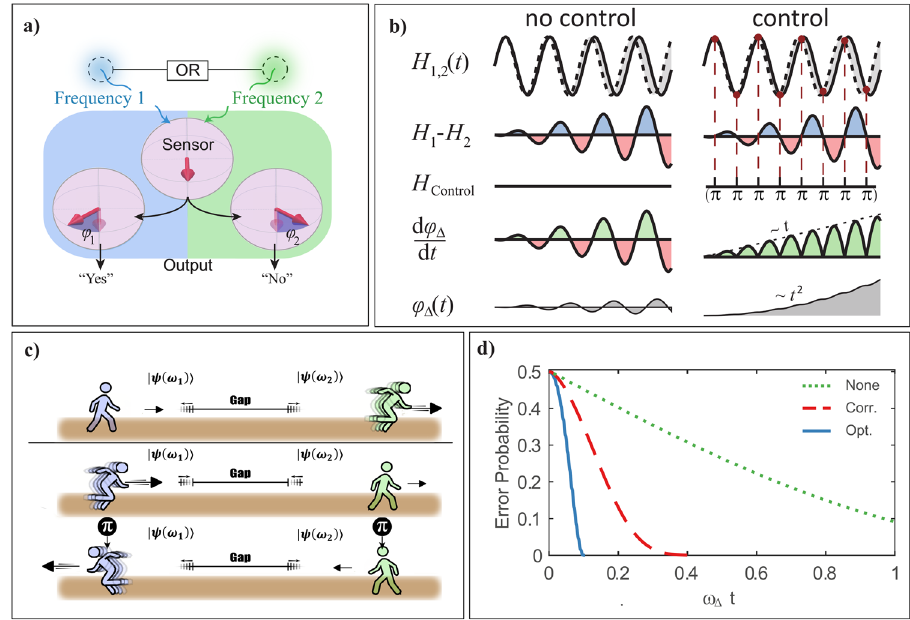
Fig. 1 Quantum-frequency discrimination. a The sensor state is tailored to depend on each frequency so that the sensor is driven in orthogonal directions. Readout of the state provides a “ Yes/No ” answer. The task is to correctly identify the frequency with highest fi delity in the shortest time. b Phase accumulation for frequency discrimination. For each Hamiltonian H i t ð Þ ¼ B sin ω i t þ θ ð Þ σ Z ¼ H i t ð Þ σ Z , the sensor accumulates a different phase. Left: without control, the phase difference φ Δ oscillates and increases only slowly. Right: optimal control in this scenario implies applying π -pulses whenever the sign of H 1 – H 2 changes, leading to a monotone phase increase with t 2 . c Geometrical picture of the optimal protocol. The states of the sensor can be thought of as two runners, where the aim is to maximize the gap between them, which is equivalent to the angle between the states. The speed of each runner is proportional to H i t ð Þ . As soon as the initially slower runner becomes faster, we change their direction of motion to ensure an increasing gap. Note that the sketch just demonstrates the idea and the runners actually move on circular orbits. d Error probability as a function of time for three different strategies: optimal control and a single measurement (solid blue), this strategy is optimal and sets the fundamental error limit (see Eqs. 3 and 4). Correlated measurements (dashed . No control (dotted green). More details on this comparison are found in red), in this illustration measurement is applied every 2 π ω 1 þ ω 2 Supplementary Note